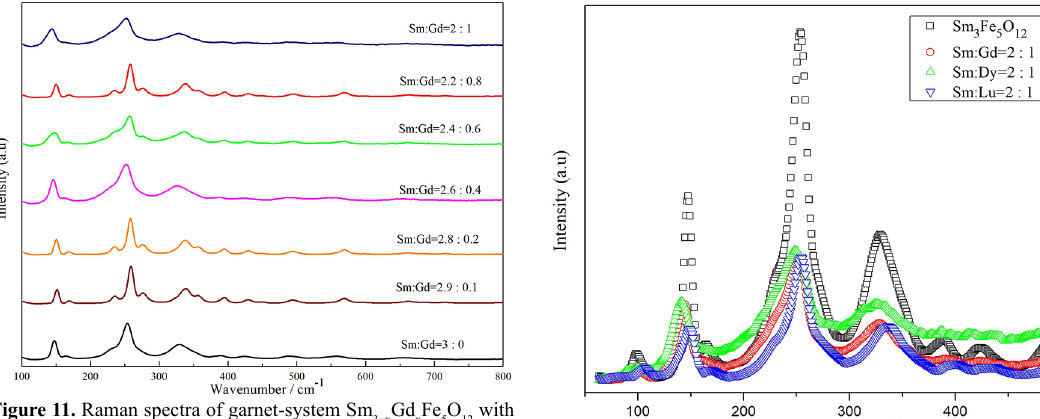
Figure 11. Raman spectra of garnet-system Sm x = 0.0, 0.1, 0.2, 0.4, 0.6, 0.8 and 1.0.